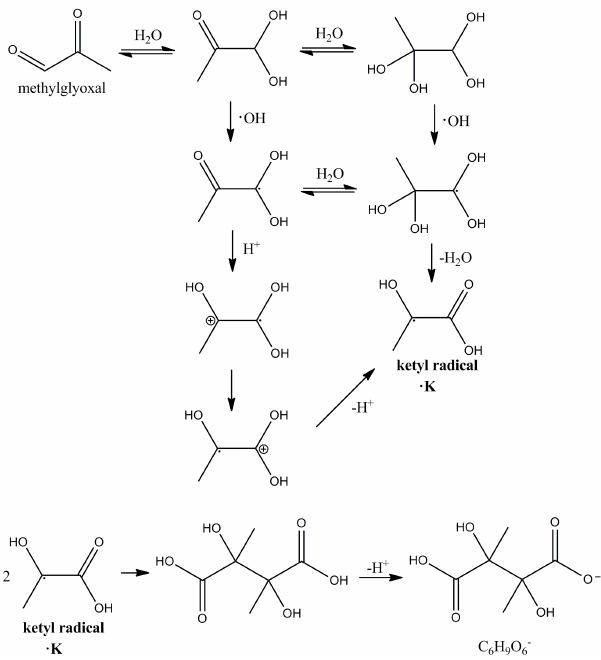
Scheme 3. The formation of ketyl radical ( OH radical oxidation of hydrated